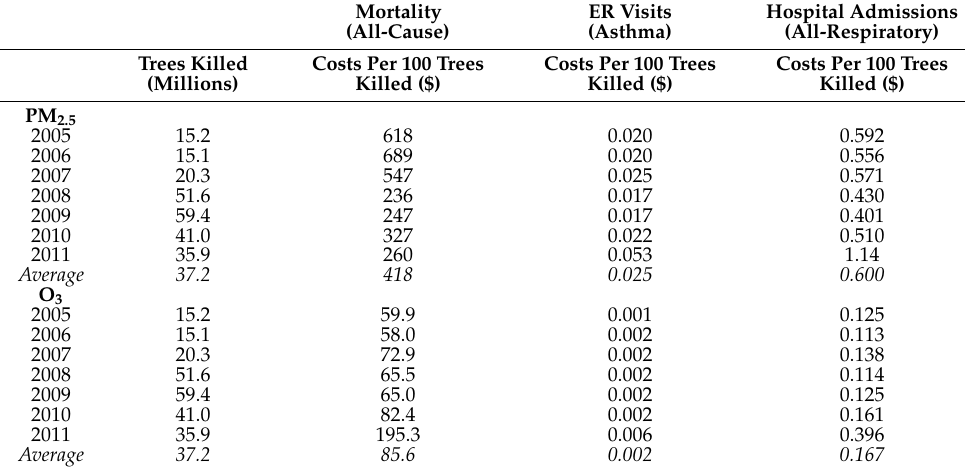
Table A1. Health costs per 100 trees killed by MPB by pollutant type and year for the Western US,